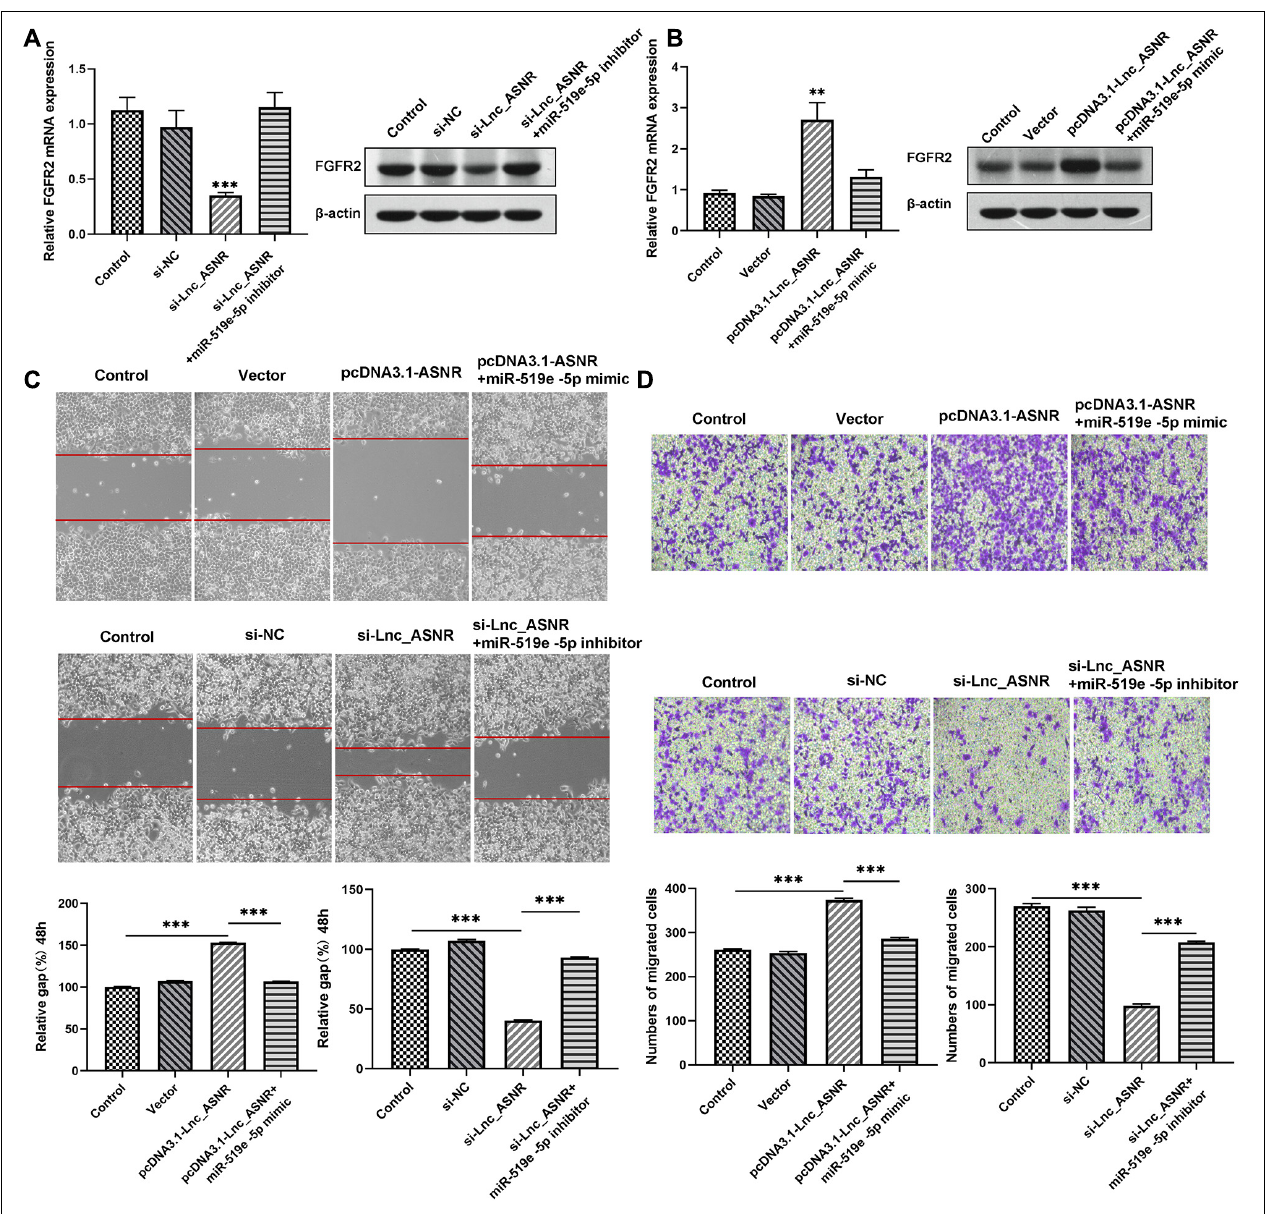
FIGURE 7 | Lnc_ASNR/miR-519e-5p axis regulates GC progression. (A) The effects of Lnc_ASNR inhibition on the expression of FGFR2. (B) The effects of Lnc_ASNR overexpression on the expression of FGFR2. (C) The rescue experiments about si-Lnc_ASNR and pcDNA3.1-ASNR for cell migration. (D) The rescue experiments about si-Lnc_ASNR and pcDNA3.1-ASNR for cell invasion. Error bars, mean ± SEM. * P < 0.05; ** P < 0.01; *** P <